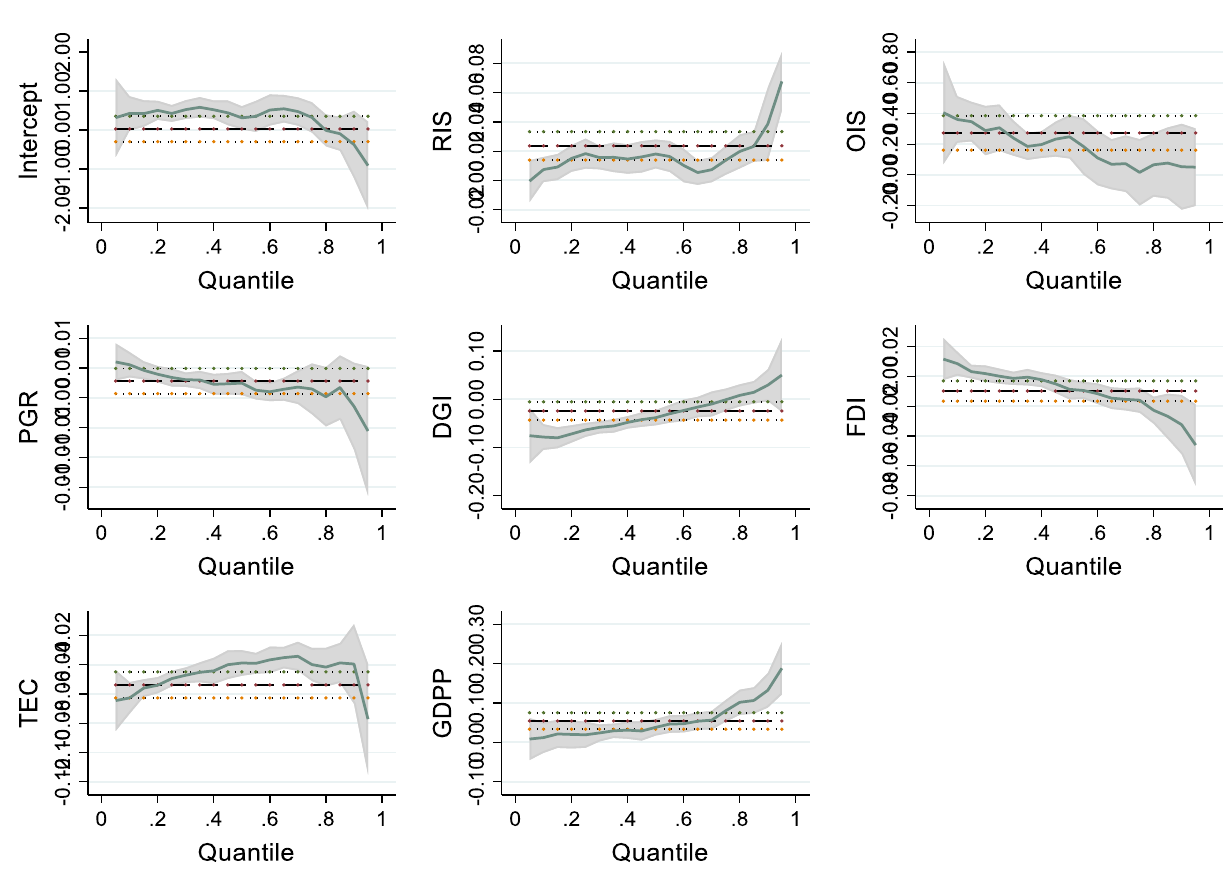
Figure 5. Quantile regression coefficient trend